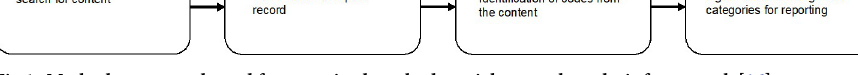
Fig 1. Method process, adapted from a mixed methods social network analysis framework